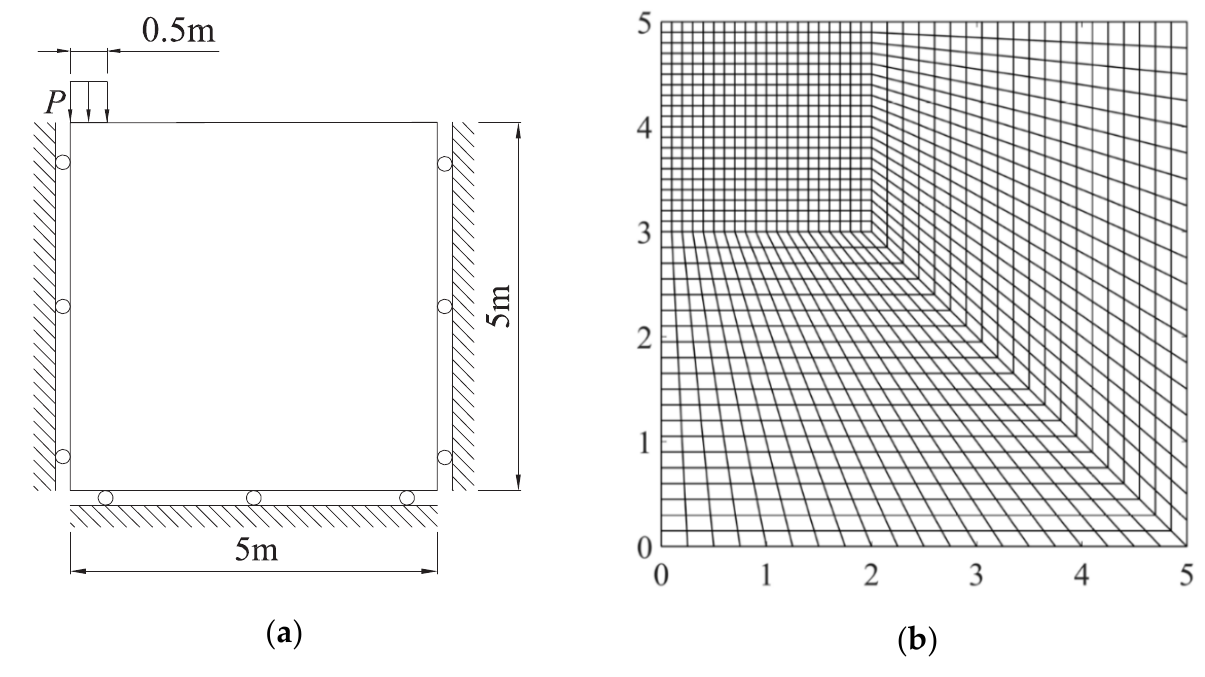
Figure 3. Strip footing: ( a ) problem geometry; ( b ) adopted mesh.